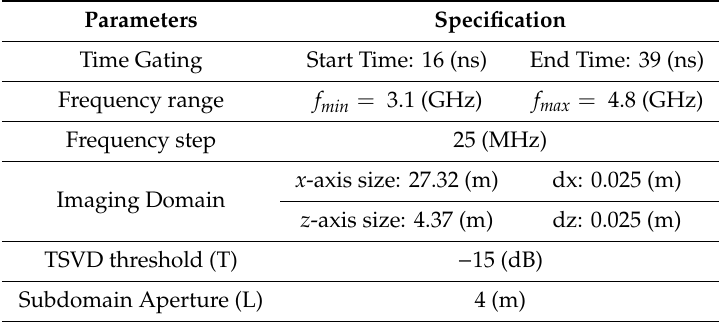
Figure 15. Test 2-Track 2: ( a ) raw data; ( b ) east–north UAV positions estimated by GPS (solid blue line) and CDGPS (solid red line), along-track direction defined by GPS (dashed blue line) and CDGPS (dashed red line); ( c ) UAV Altitude estimated by GPS (solid blue line) and CDGPS (solid red line), average altitude defined by GPS (dashed blue line) and CDGPS (dashed red line). Table 5. Signal Processing Parameters: Track 1.